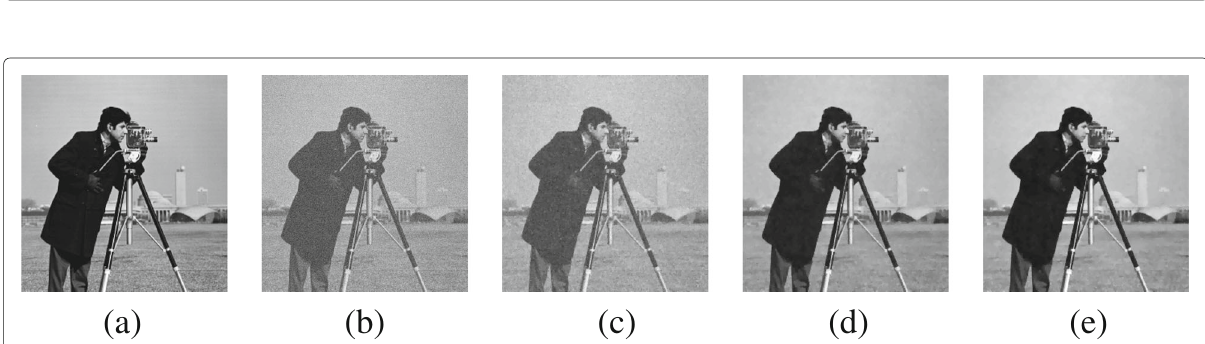
Fig. 6 Denoised results on “Cameraman” image; a true image; b noisy image with σ = 24; c processed with method M1; d processed with method M2; e processed with method M3